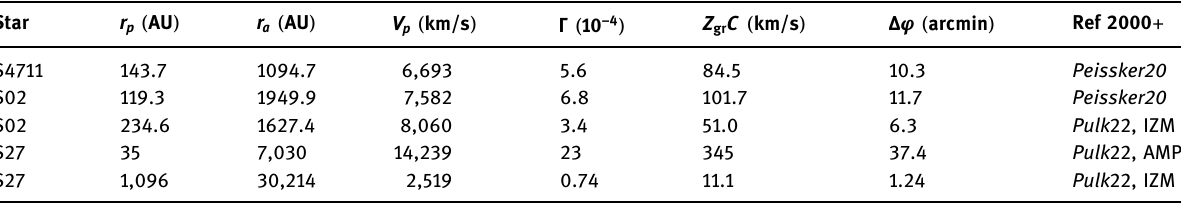
Data for S4711 correspond to its orbit in Table